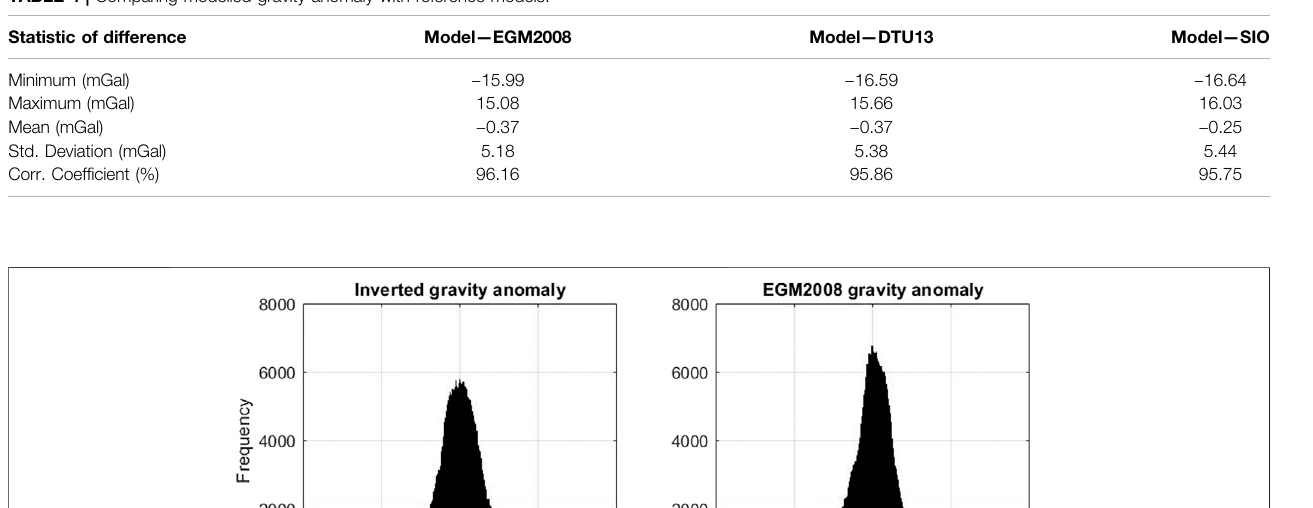
Frontiers in Earth Science |